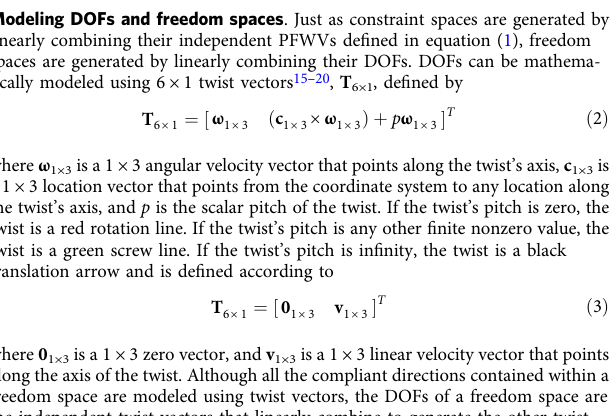
Supplementary Fig. 8b, is the set of planes that intersect the rotation ’ s axis. Thus, according to Eq. (4), m = 5 total independent PFWVs must be selected from within this constraint space because its freedom space contains n = 1 DOF. Since the constraint space consists of intersecting planes, which according to Supplementary Fig. 6 are each the constraint space of a single blade element (i.e., 3 DOF Type 1), a blade element could be selected from within any one of the intersecting